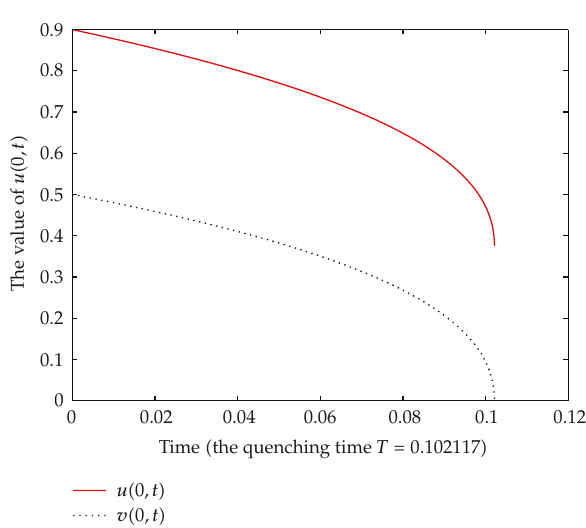
Figure 7: Evolution at the point x 0 (cid:3) 0 of the solution (cid:5) p 1 (cid:3) q 1 (cid:3) p 2 (cid:3) q 2 (cid:3) 1 (cid:6) .